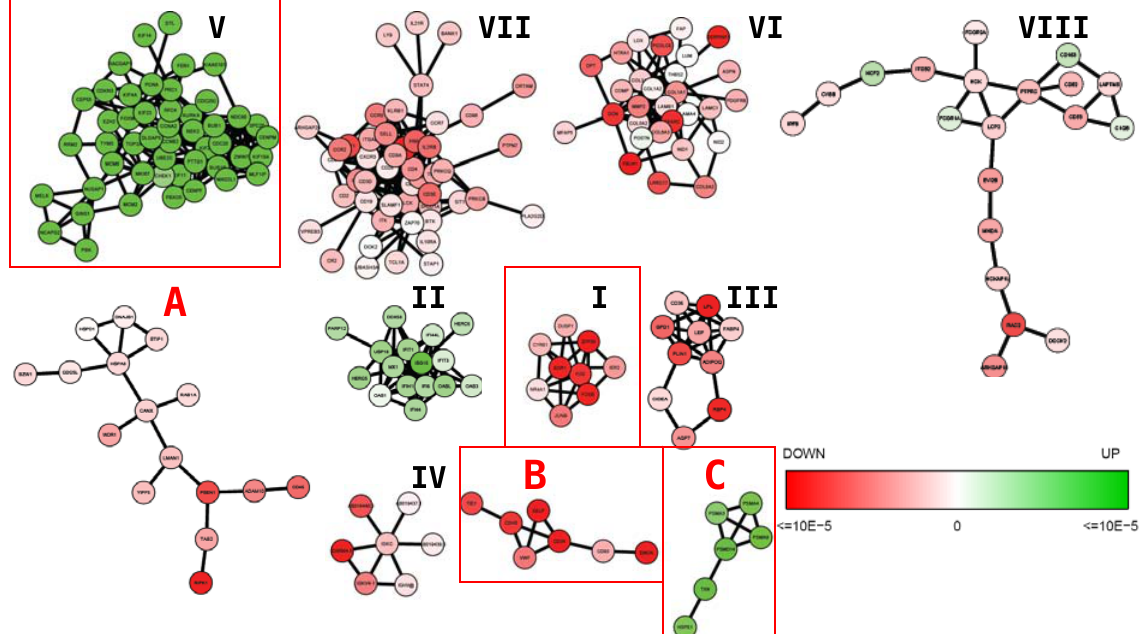
Figure 4: Sub network markers identified with an early integration approach (i.e. applying the procedure to find sub networks on the data of all six studies concatenated). Sub networks marked with black roman numerals correspond to the reported eight consistently identified sub networks, also indicated in Fig 2. Sub networks A, B and C were newly identified and were enriched for the GO terms: unfolded protein binding (GO:0051082), cell-cell adhesion (GO:0016337) and proteasome complex (GO:0000502) respectively. Significant sub networks ( T <= 0.05) showing a functional enrichment for at least one GO category were reported for this analysis only. Sub networks marked by red bounding boxes remained significant after correction for multiple